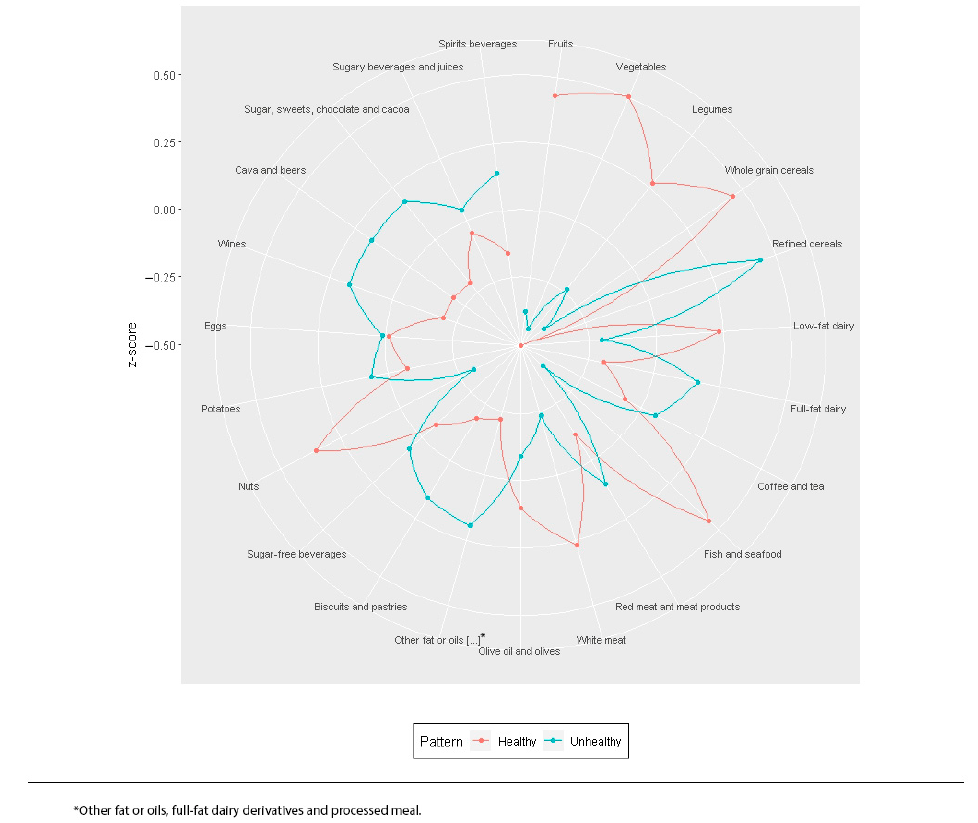
Figure 2. Dietary patterns identified by cluster analysis.